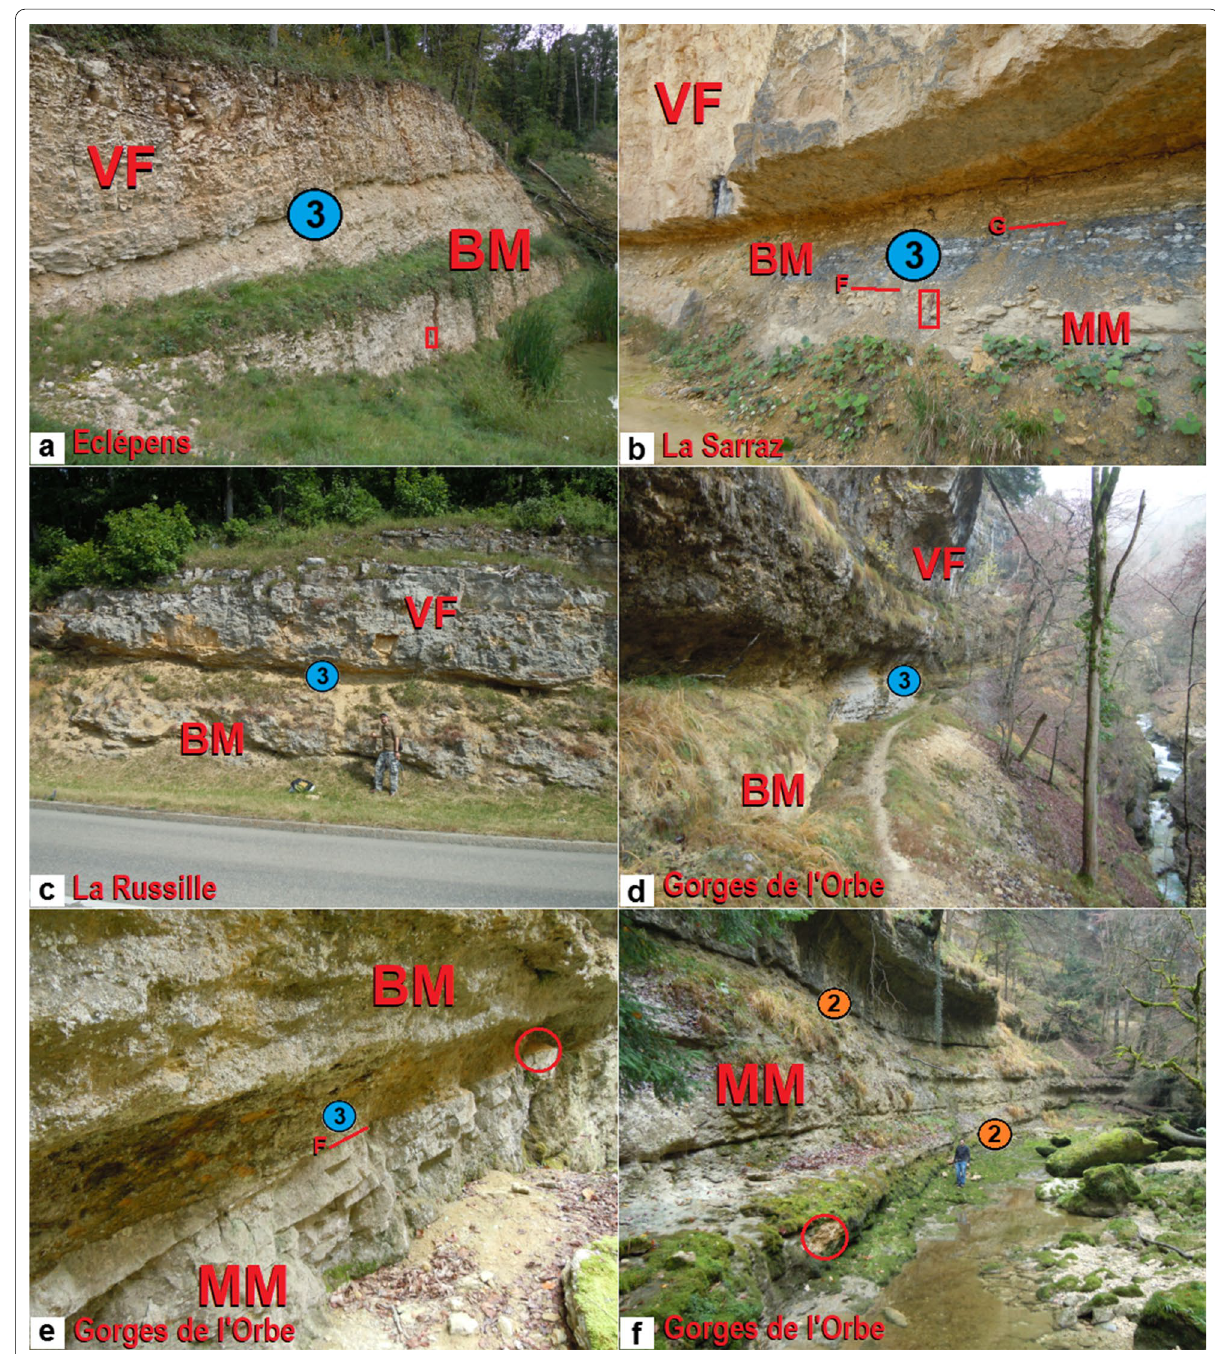
Fig. 8 Saars Formation of the Vaud Jura (central Jura Mountains). a Eclépens railway trench section. b Upper La Sarraz‑Les Buis quarry section (cf. De Kaenel et al., 2020). c Upper La Russille section. d – f Gorges de l’Orbe section, upper part ( d ), middle part ( e ) with ammonite Pseudometahoplites sp. (in red circle Ø 31.5 cm; cf. De Kaenel et al., 2020) and lower part ( f ) with nautilid Cymatoceras pseudoelegans (d’Orbigny, 1840) located in red circle. Captions: BM: Bôle Member; MM: Montcherand Member; VF: Vallorbe Formation. For the reported discontinuities (F, G) and ostracod assemblages (colored circles 2, 3), see Figs. 10 and 11. The hammer ( a , b : red frame) is 31.5 cm